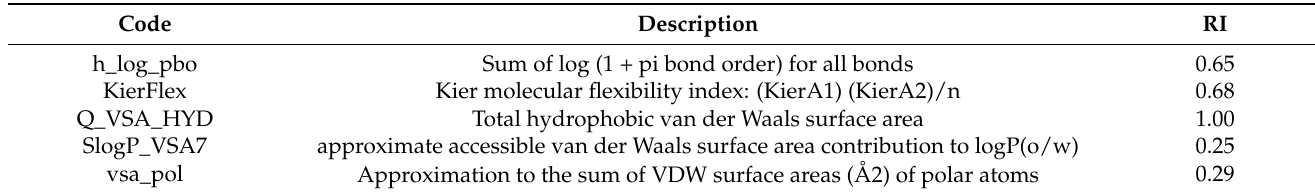
Table 1. Specification of the five descriptors included in the final QSAR model.